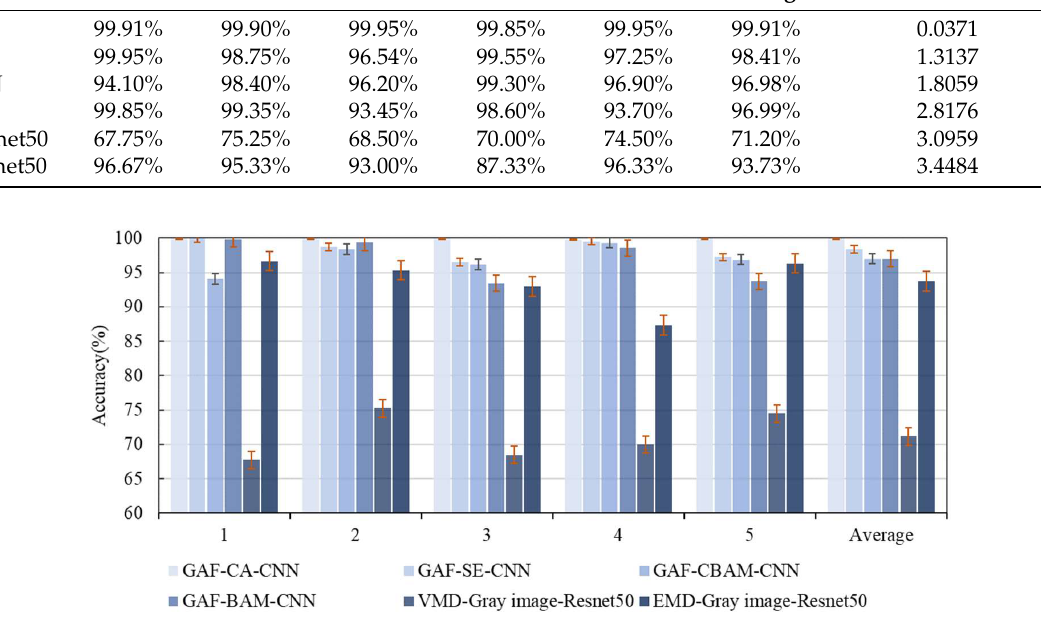
Figure 22. Comparison results between seven methods on dataset B.